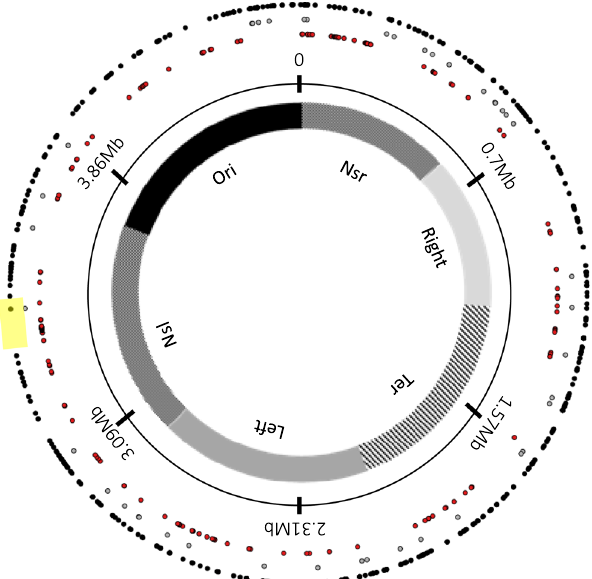
Fig. 1 Distribution of all insertion sites of IS elements in the genome sequences of the ancestor and 264 evolved clones. Insertion sites are mapped onto the chromosome of the LTEE ancestor, REL606. The inner circle indicates the six chromosomal macrodomains 41 : Ori origin; Nsr non- structured right domain; Right right domain; Ter terminus domain; Left left domain; Nsl non-structured left domain. The next circle shows the chromosomal coordinates. Gray and black dots show the location of IS elements in the ancestor and evolved clones, respectively. Red dots show the location of essential genes 20 . The 152-kbp “ IS-empty ” chromosomal region is highlighted in yellow. Source data are provided as a Source Data fi le.